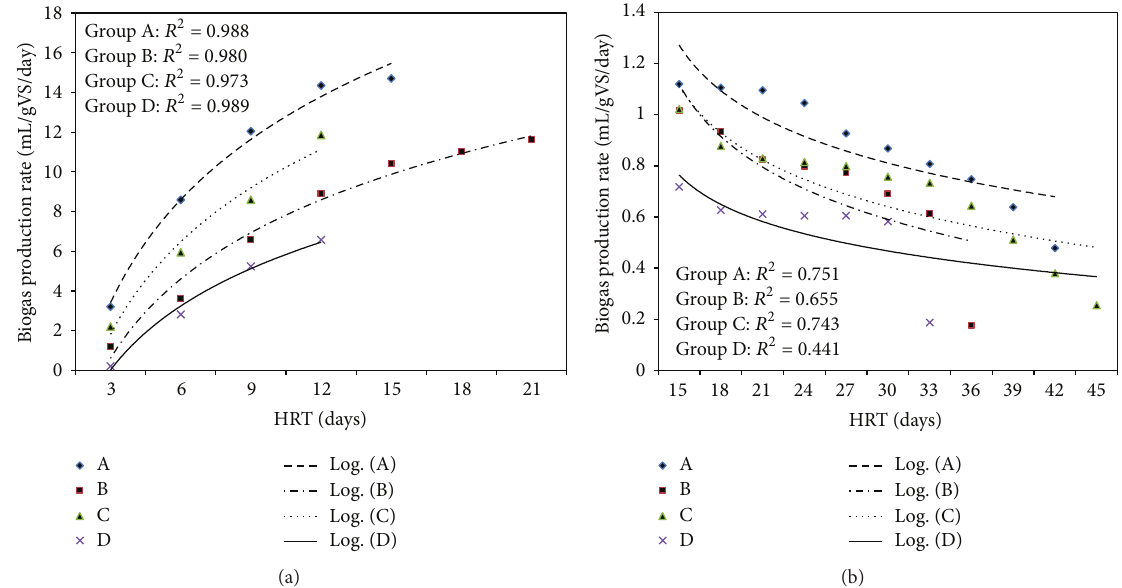
Figure 7: (a) Exponential plot of the ascending limb of biogas production rate for thermally treated (groups A and B), untreated (group C) biomass and inoculum (group D). (b) Exponential plot of the descending limb of biogas production rate for thermally treated (groups A and B), untreated (group C) biomass and inoculum (group